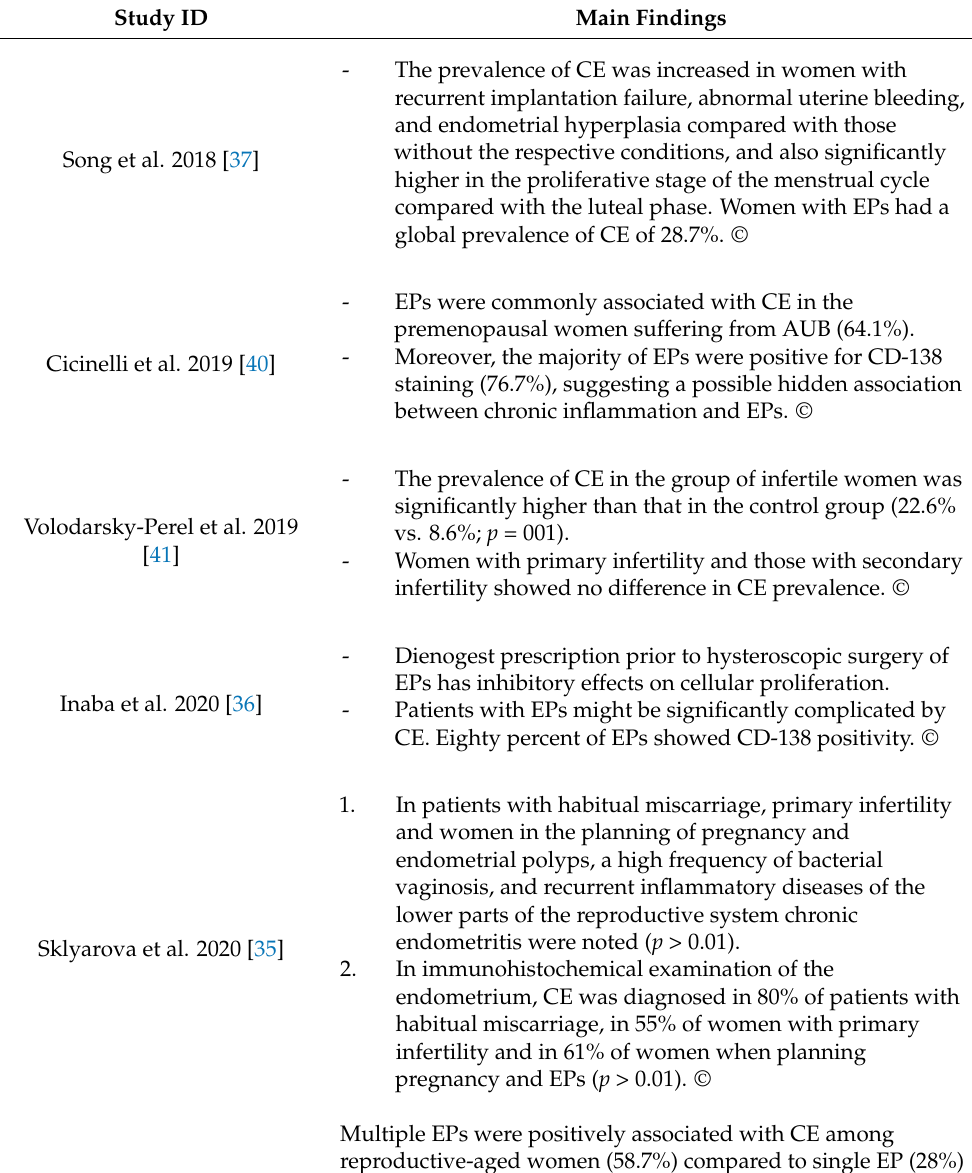
Table 2. Main findings of included